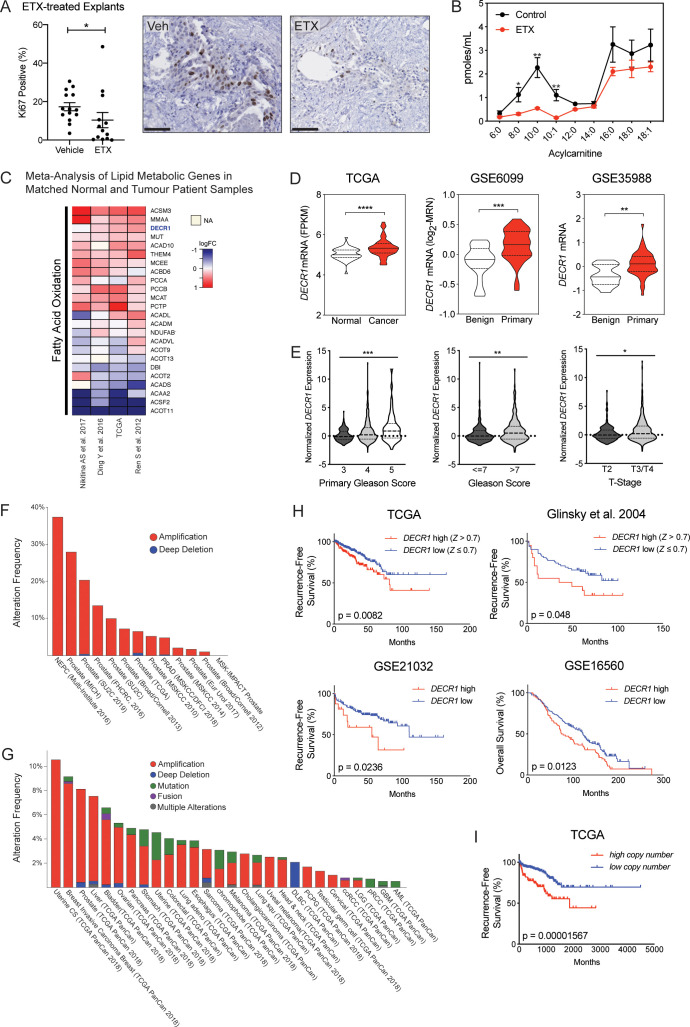
Fatty acid β-oxidation genes are overexpressed in prostate cancer and targeting this process is effective in patient-derived human prostatic ex vivo tumor explants.(A) Etomoxir reduced cell proliferation in patient-derived human prostatic ex vivo tumor explants. Tissues were treated with 100 µM etomoxir for 72 hr, sections were fixed in formalin, paraffin embedded and stained against the proliferative marker Ki67 (n = 13) (scale bar = 50 µm). (B) Etomoxir (100 µM) decreased acylcarnitine species, the products of CPT1 activity. Acylcarnitines secreted to the conditioned medium were measured after 72 hr treatment of PDEs (n = 9). (C) A meta-analysis of fatty acid oxidation genes using four clinical datasets with malignant and matched normal RNA-sequencing data (n = 122). Genes were rank-ordered on the basis of their meta effect size scores in PCa malignant tissues versus matched normal tissues. (D) Violin plots demonstrate DECR1 mRNA overexpression in PCa primary/malignant tissues compared to normal/benign tissues in three independent datasets. (E) DECR1 mRNA expression is associated with PCa primary Gleason score, total Gleason score (>7) and diseases stage (T-stage). Data were extracted from TCGA PCa dataset. (F) Histogram displaying DECR1 mutation and copy-number amplification frequency across 13 PCa genomic datasets, and (G) across 28 tumor types. Histograms were obtained from CbioPortal platform. (H) DECR1 mRNA expression is associated with shorter relapse-free survival in TCGA PCa, Glinsky et al., 2005 and GSE21032 datasets, and shorter overall survival rates in GSE16560 dataset. (I) DECR1 copy number amplification frequency is associated with shorter relapse-free survival in TCGA PCa dataset. Data in (A) are represented as as the mean ± s.e.m and were statistically analysed using a Wilcoxon matched-pairs signed rank test. Data in (B) are represented as the mean ± s.e.m and were statistically analysed using two-tailed Student’s t-test. Data in (D) and (E) are represented as violin plots in GraphPad prism: the horizontal line within the violin represents the median, and were statistically analysed using a Mann-Whitney two-tailed t-test. Data in (H) and (I) were statistically analysed using a two-sided log-rank test. *p<0.05, **p<0.01, ***p<0.001 and ****p<0.0001.